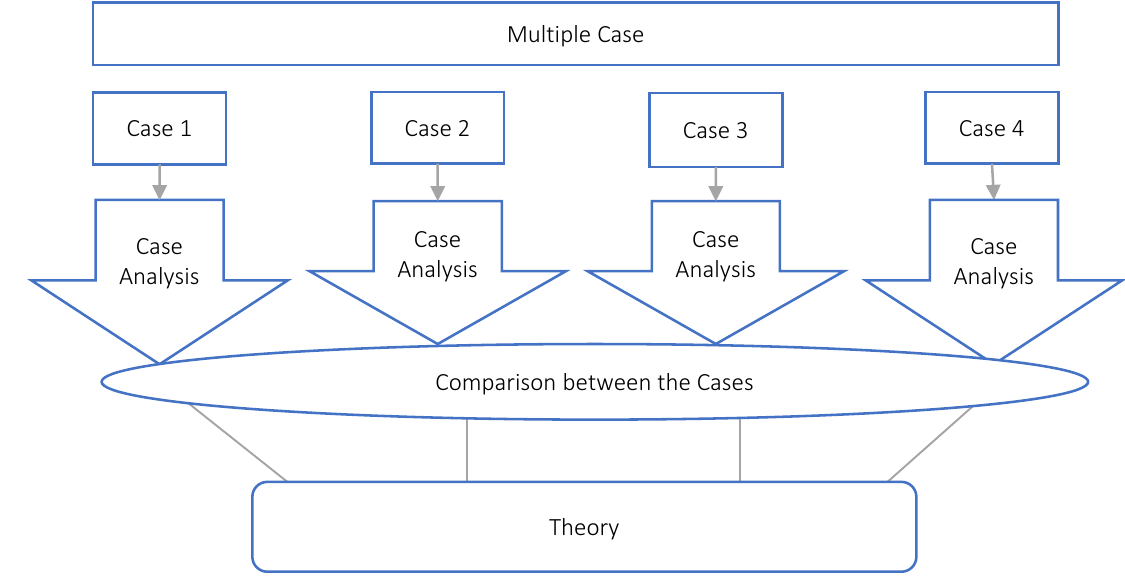
Figure 3. Multiple case